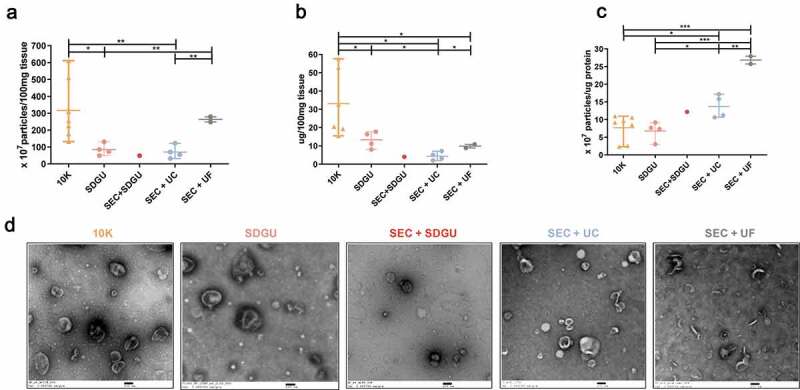
Characterization of mouse bdEVs. (a) Particle concentrations of mouse bdEVs separated by different methods were measured by NTA (Particle Metrix, normalized per 100 mg tissue). (b) Protein concentration of mouse bdEVs separated by different methods and measured by BCA protein assay kit (per 100 mg tissue). (c) Ratio of particles to protein (particles/µg). (a–c): Data are presented as the mean with range. *p ≤ 0.05, **p ≤ 0.01, ***p ≤ 0.001, ****p ≤ 0.0001 by two-tailed Welch’s t-test. (d) bdEVs were visualized by negative staining transmission electron microscopy (scale bar = 100 nm). TEM is representative of five images taken of each fraction from three independent tissue samples.